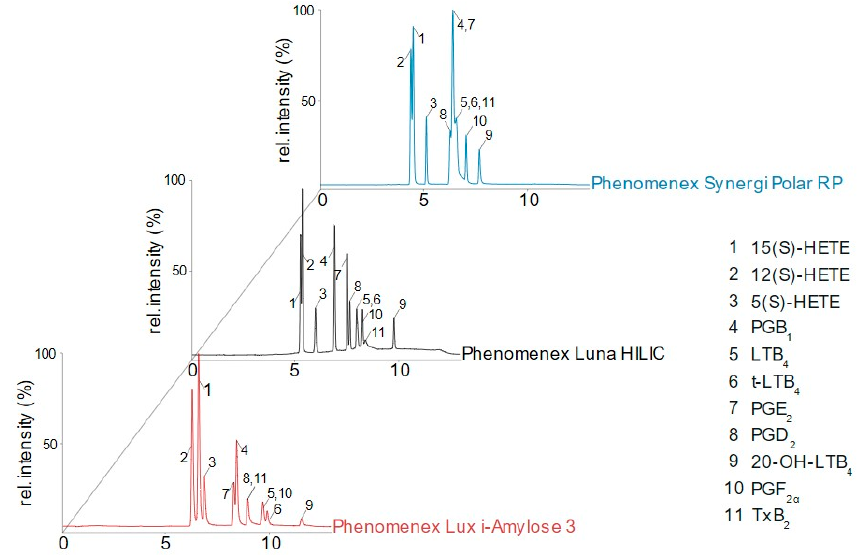
Figure 2. Chromatograms of selected columns. Exemplary, total ion count (TIC) of all measured m / z from a chiral column (LUX i-Amylose 3), an HILIC column (Luna HILIC), and a modified RP column (Synergi Polar RP) is shown.